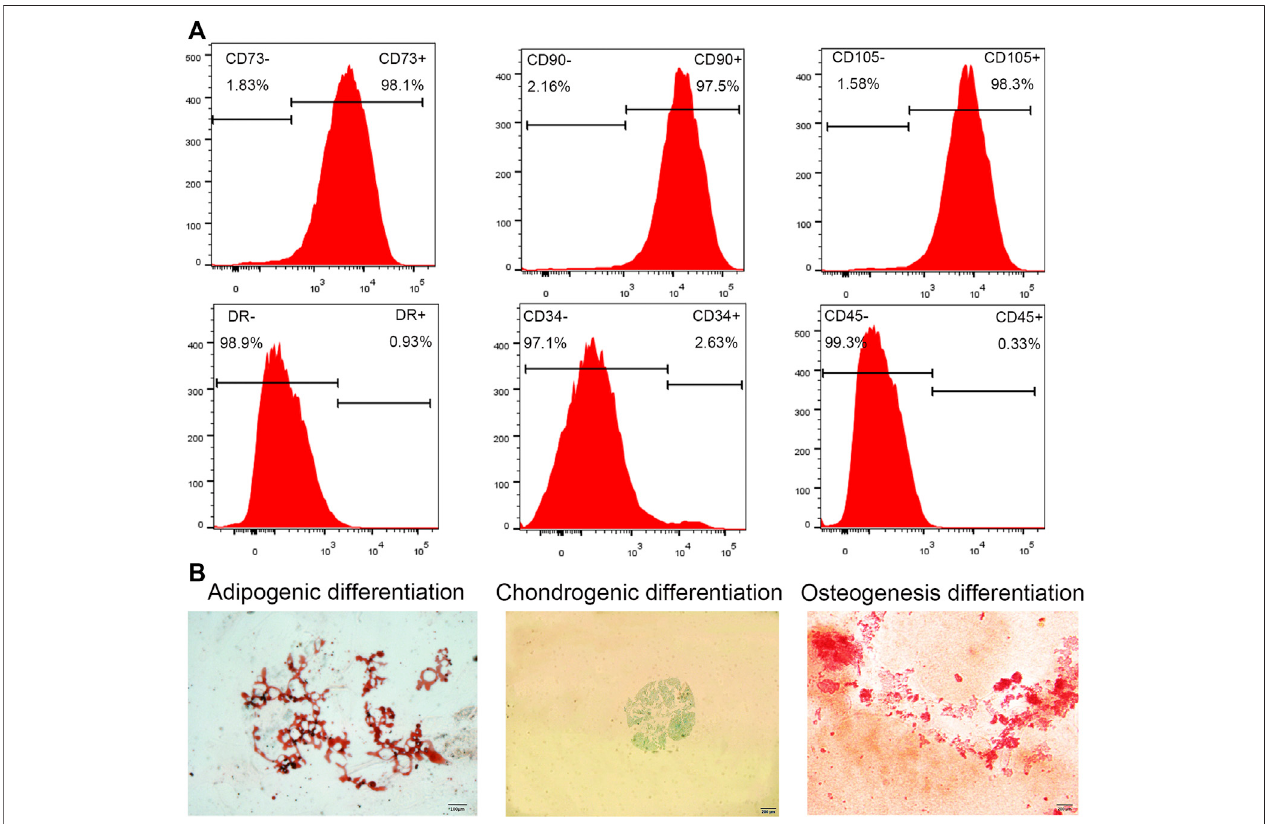
FIGURE2| Cellphenotypeidenti fi cationandcelldifferentiation. (A) FlowcytometryanalysisshowedhighexpressionofthecellsurfacemarkersCD105,CD90,and CD73, while CD45, CD34, and HLA-DR expression was absent. (B) Three lineage differentiation of NP-MSCs. Oil red O staining of NP-MSC intracellular lipid vacuoles indicated adipogenic differentiation; Alcian blue staining of cartilage indicated chondrogenic differentiation; Alizarin red staining of calcium nodules indicated osteogenic differentiation.